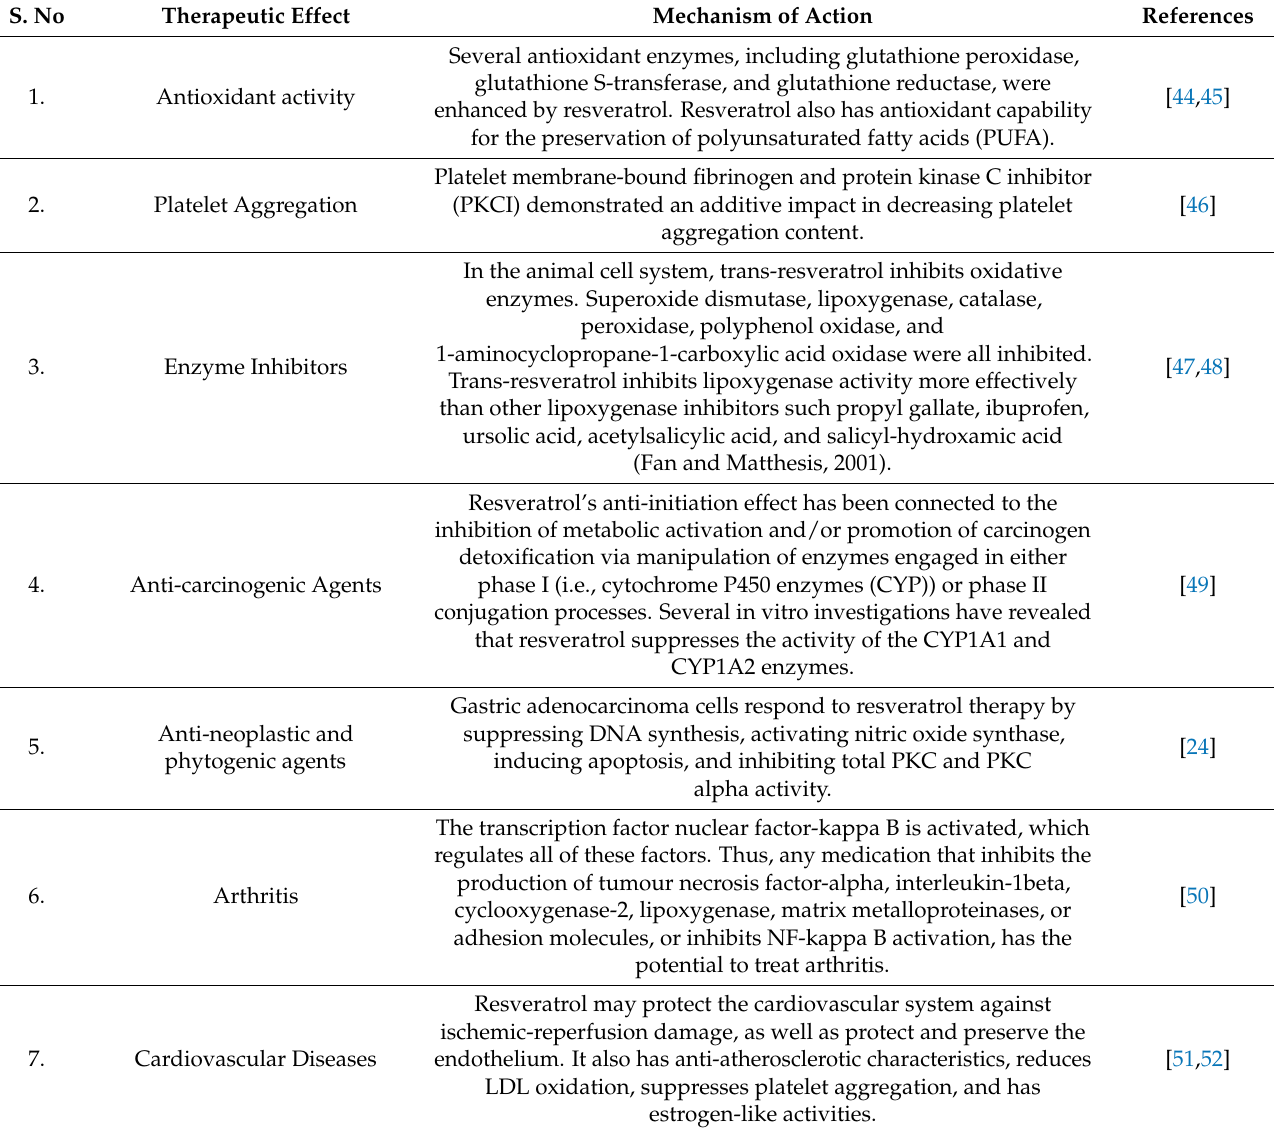
Table 3. Mechanism of action of Resveratrol for different